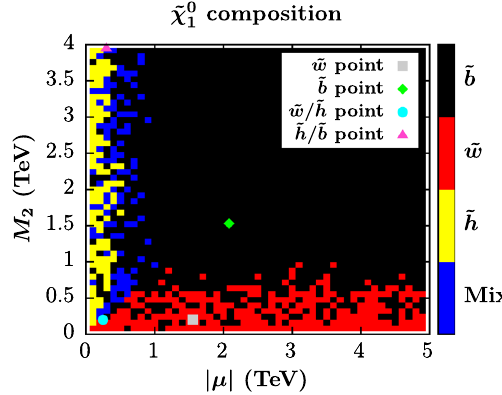
Fig. 7 Composition of the lightest neutralino ˜ χ 0 in the | μ | – M 2 plane. 1 A point is dominantly bino-like ( ˜ b , black) for | N 11 | 2 > 0 . 5, dominantly wino-like ( ˜ w , red) for | N 12 | 2 > 0 . 5, dominantly higgsino-like ( ˜ h , yel- low) for | N 13 | 2 > 0 . 5 or | N 14 | 2 > 0 . 5, or a mix of all components (“mix”, blue) in any other case, i.e. if neither | N 1 i | 2 is larger than 0.5. For later discussion four specific points referred to as ˜ w, ˜ b , ˜ w/ ˜ h , and ˜ h / ˜ b are